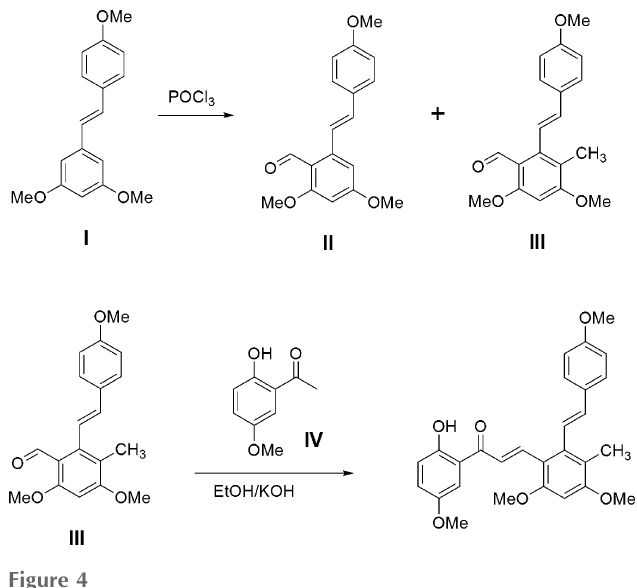
Figure 4 Synthetic scheme for the preparation of